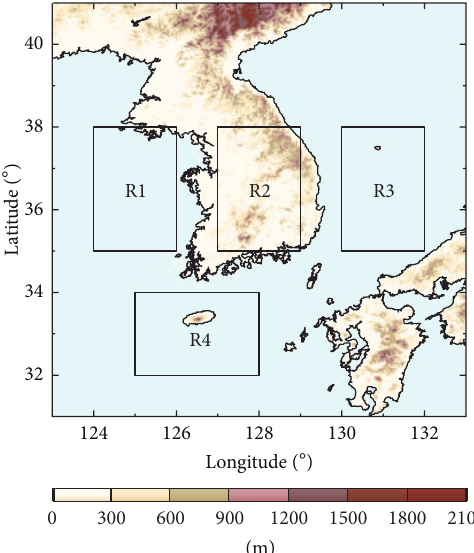
Figure 1: Topographic map of Republic of Korea with selected regions from R1 to